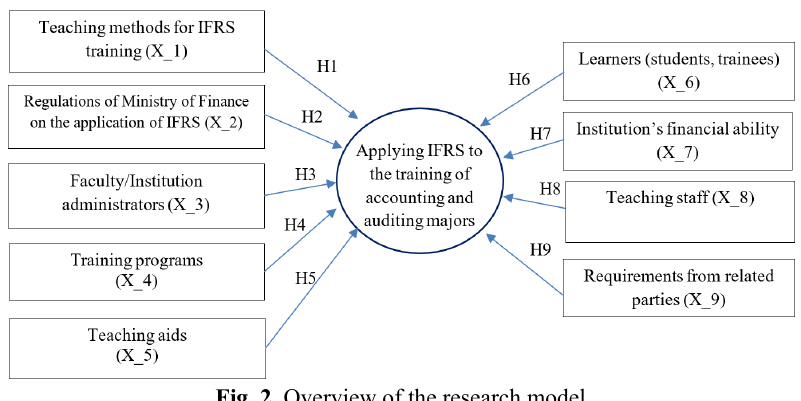
Fig. 2. Overview of the research